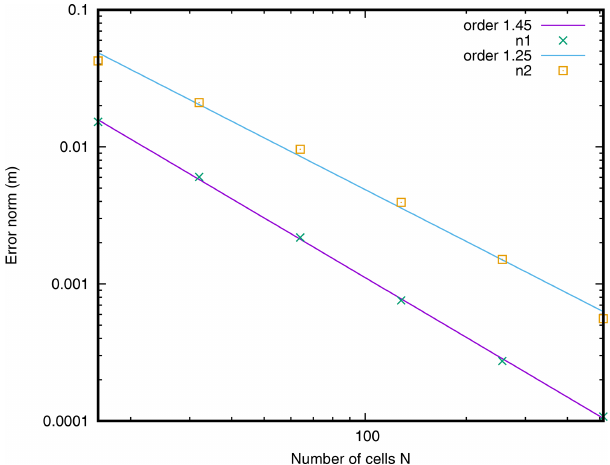
Figure 4. Convergence of the different error norm when the resolu- tion is